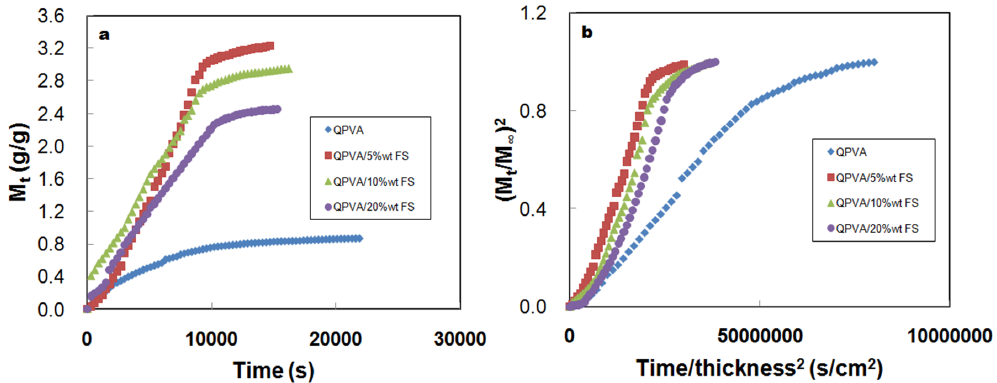
Figure 5. ( a ) Water vapor uptake at different elapsed times; and ( b ) water relative uptake studies as a function of the square root of time divided by membrane thickness for pristine QPVA, and the QPVA/5% FS, QPVA/10% FS and QPVA/20% FS nanocomposite membranes.